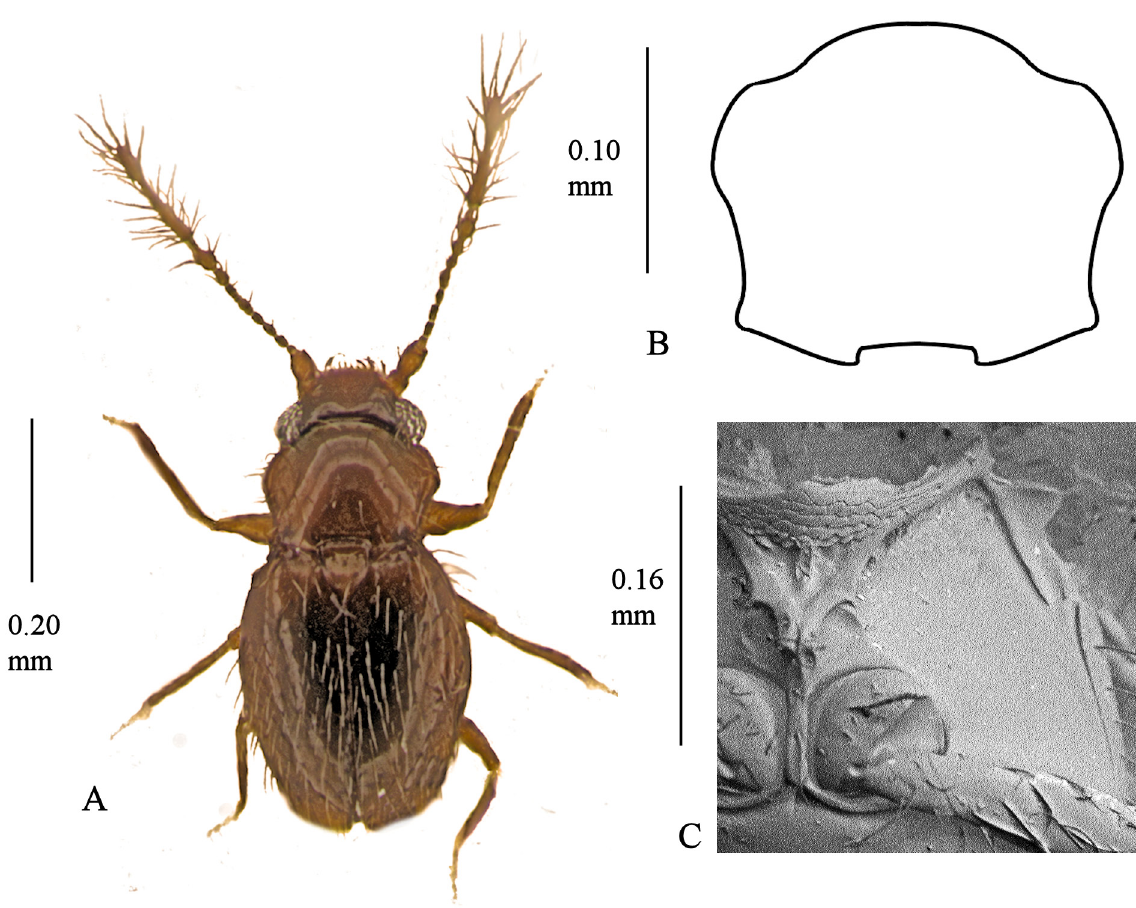
Fig. 106 . Cissidium tigrum Darby, 2015. A . Habitus. B . Pronotum. C . Mesoventrite showing median process of collar, effaced lateral margin, mid-keel and keel,